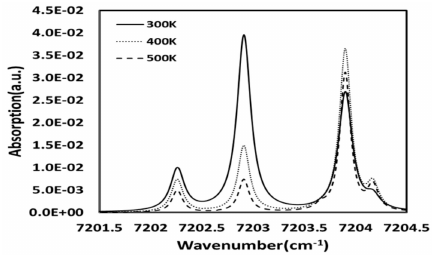
Figure 1. Theoretical H 2 O absorption